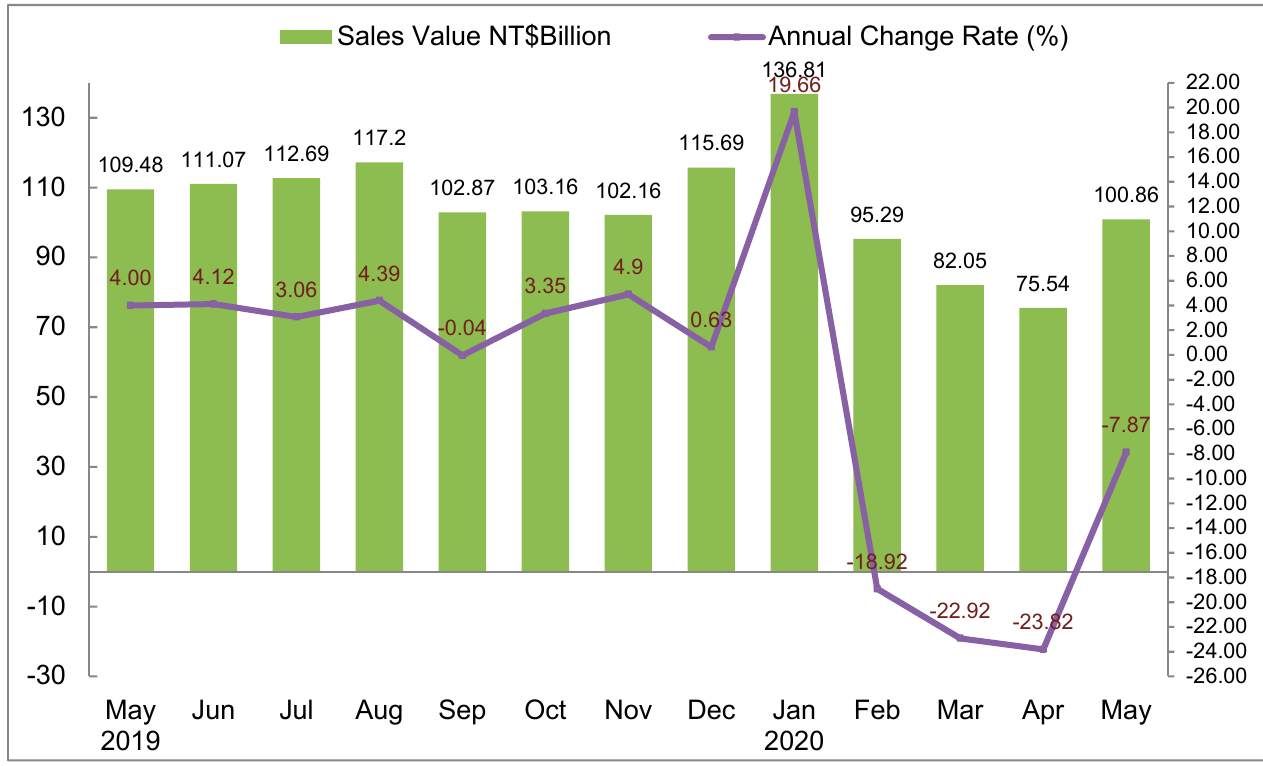
Figure 1. Statistics related to restaurant sales index and annual change rate from May 2019 to May 2020; Source: [29].